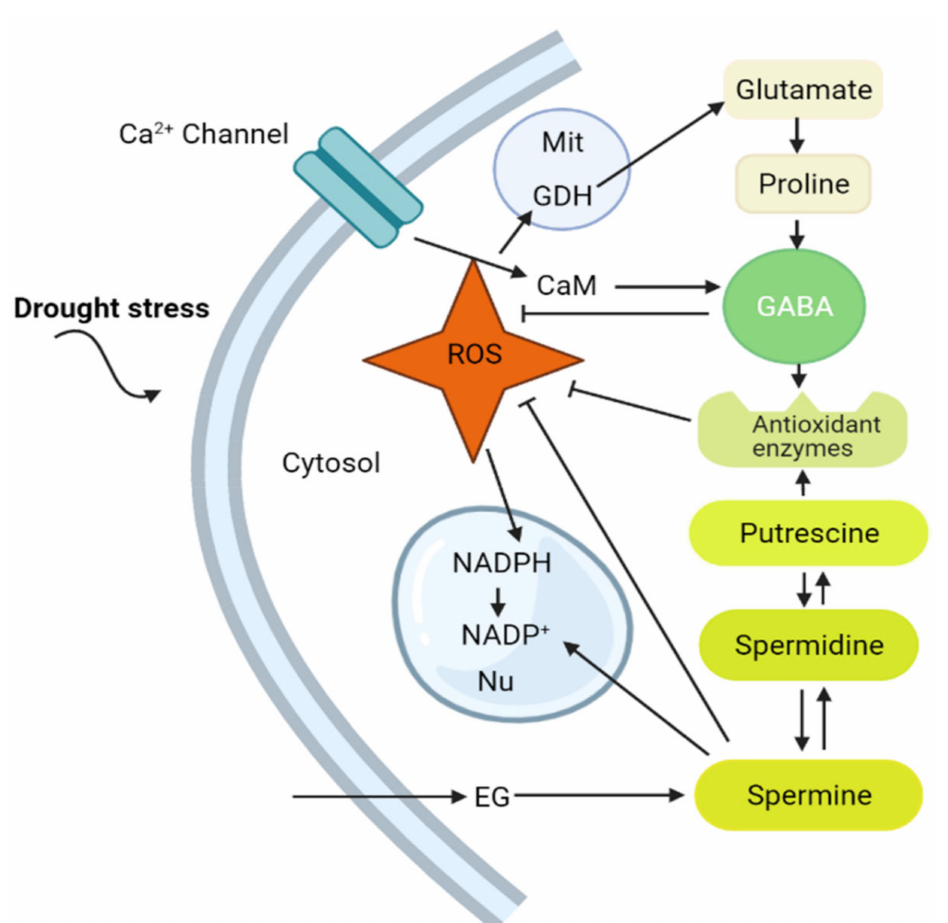
Figure 4. The interrelationship between GABA and PAs mediating ROS in plants. ROS stimulate the activity of GDH in the mitochondria, resulting in the synthesis of Glu, a precursor to GABA. GABA accumulates in response to drought stress via CaM protein-mediated activation of the GAD enzyme and Ca 2+ signaling. When drought stress occurs, PA biosynthesis increases, which results in GABA biosynthesis. GABA and PAs boost antioxidant enzyme (AE) activity, impairing the synthesis and function of ROS in plant cells. Abbreviations: Ca 2+ , calcium; CaM, calmodulin protein; ROS, reactive oxygen species; GDH, glutamate dehydrogenase; Mit, mitochondria; NADP, nicotinamide adenine dinucleotide phosphate; Nu, nucleus; EG, exogenous